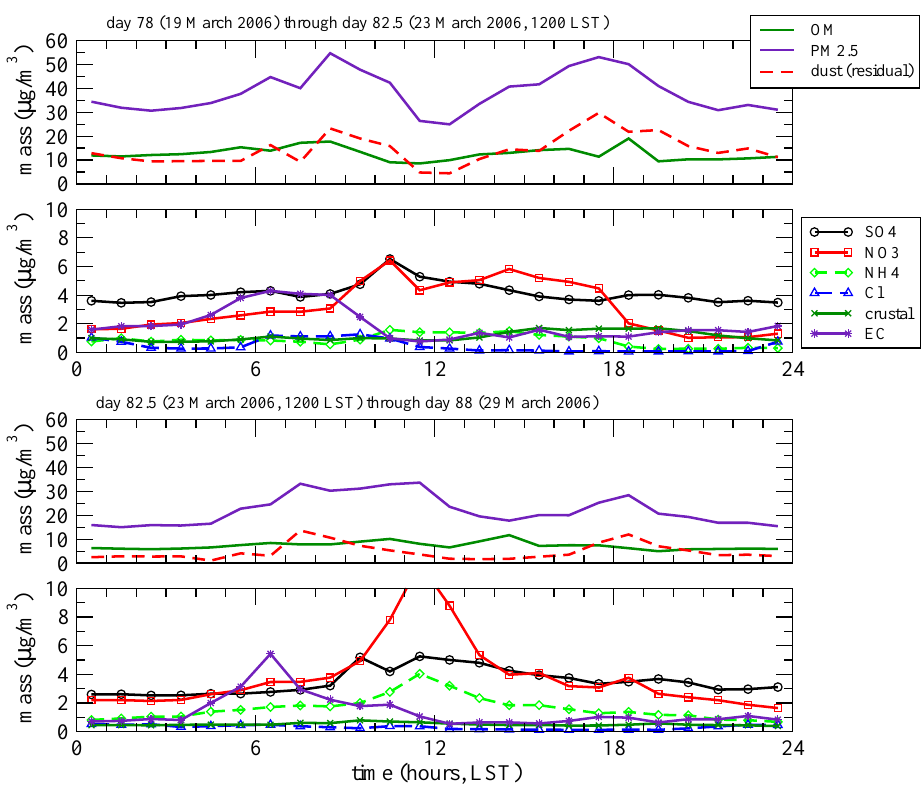
Fig. 2. Diurnally averaged times series of chemical species and PM 2 . 5 mass. The two upper panels show these constituents during the clear period of little precipitation, while the two lower panels show the same constituents during the showery period. For clarity, the mass measurements are broken down into two plots: OM, PM 2 . 5 , and dust compose one plot, while SO 4 , NO 3 , NH 4 , Cl, crustal materials, and EC compose the second plot. Note that PM 2 . 5 mass is significantly lower during the showery